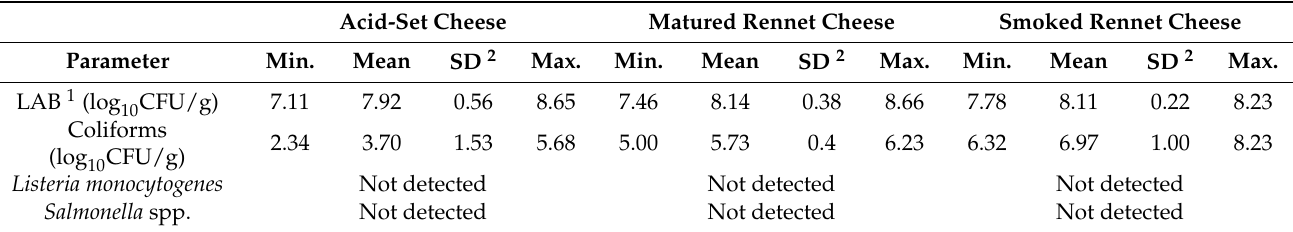
Table 2. Goat’s milk cheese microbiological results.